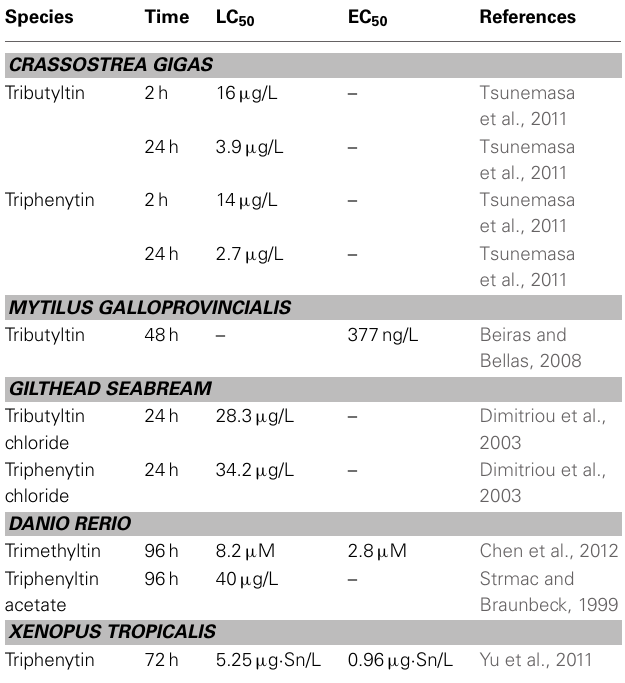
Table 1 | Comparison of developmental toxicity of organotin compounds in